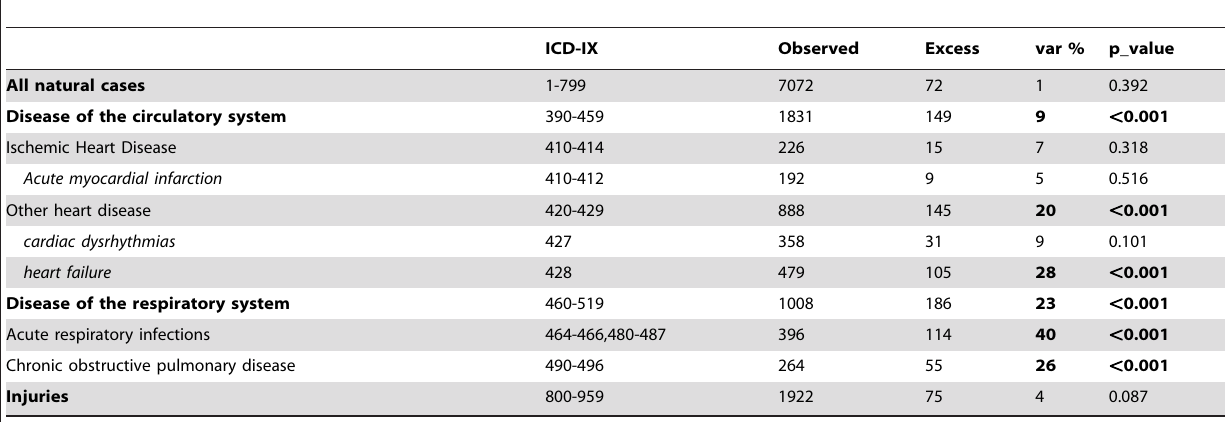
Table 4. Monthly observed, excess and percent variation in cause-specific ER visits among the very old (75 + years) during the month of February 2012 in